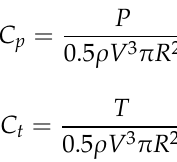
Figure 7. The simulation domain of double wind turbines.